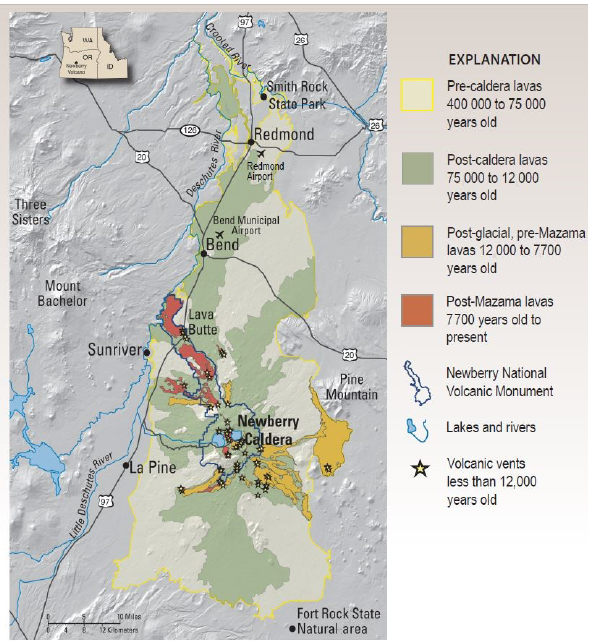
Figure 1. Lava flows and young volcanic vents at Newberry Vol- cano. The USGS continues to study and monitor the area (from Donnelly-Nolan et al., 2011). Figure 2 below shows the position of the NDDP target